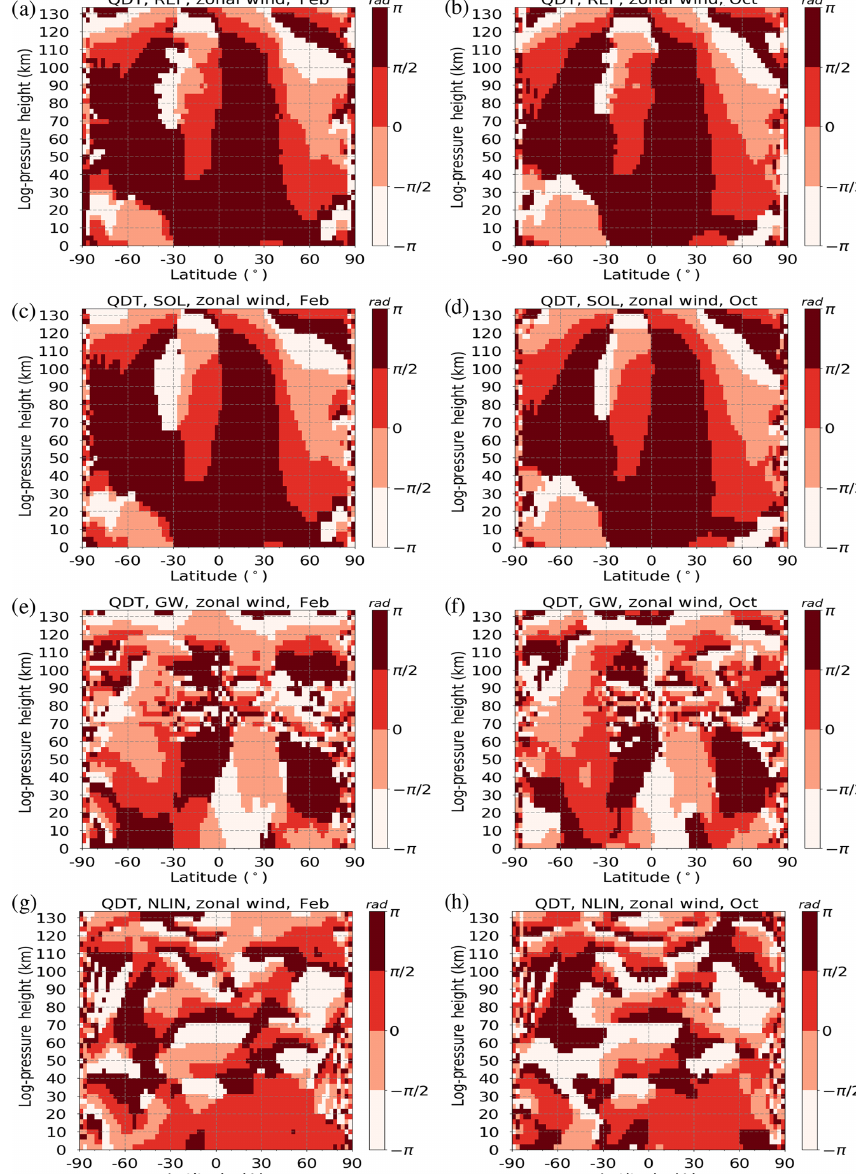
Figure 8. Same as Fig. 6 but for QDT zonal wind